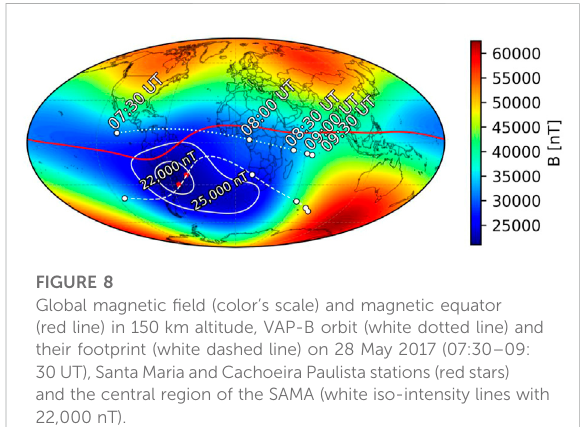
FIGURE 8 Global magnetic fi eld (color ’ s scale) and magnetic equator (red line) in 150 km altitude, VAP-B orbit (white dotted line) and their footprint (white dashed line) on 28 May 2017 (07:30 – 09: 30UT), Santa Maria and CachoeiraPaulista stations (redstars) and the central region of the SAMA (white iso-intensity lines with 22,000